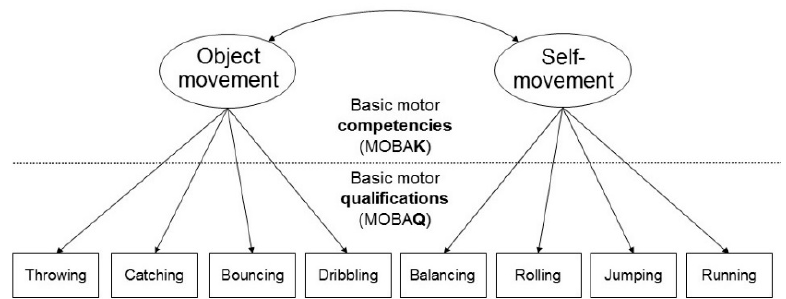
Figure 1. Competency structure model of basic motor competencies for the third grade [47].